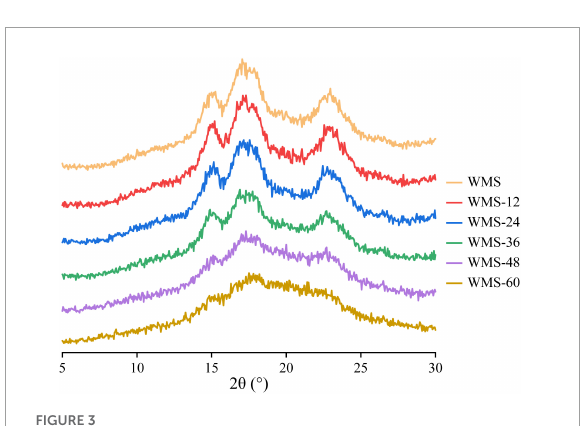
FIGURE4 Fourier transform infrared spectra of native starch and fermented starch. WMS, native waxy maize starch; WMS-x, waxy maize starch fermented for x h.